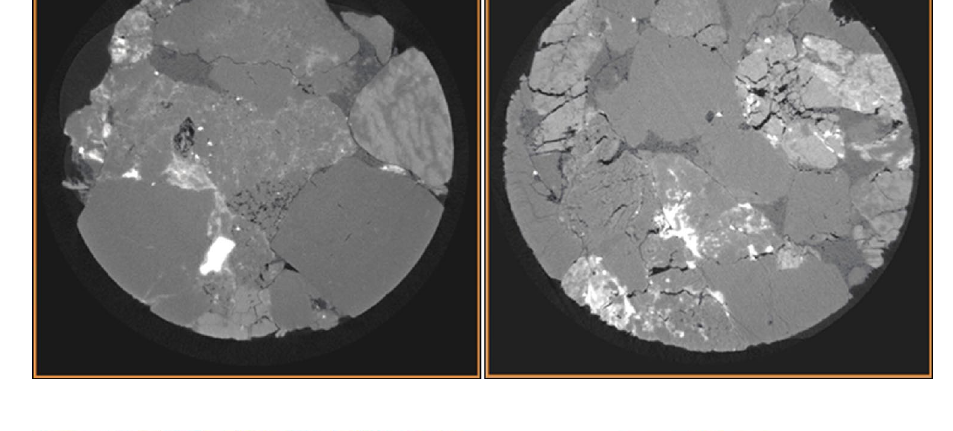
Fig. 5 Pore space of 3D digital cores of No.1 and No. 2 rock samples from Ybei X